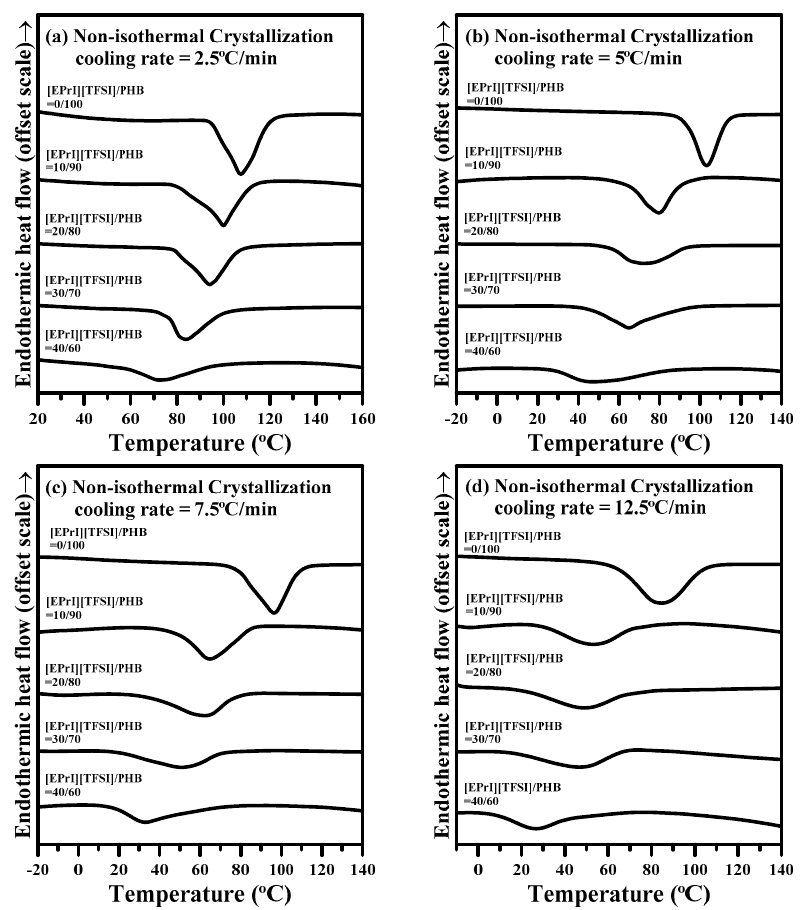
Figure 5. DSC results of non-isothermal crystallization of [EPrI][TFSI]/PHB blends with a different cooling rate: ( a ) 2.5 °C/min; ( b ) 5 °C/min; ( c ) 7.5 °C/min; and ( d ) 12.5 °C/min.